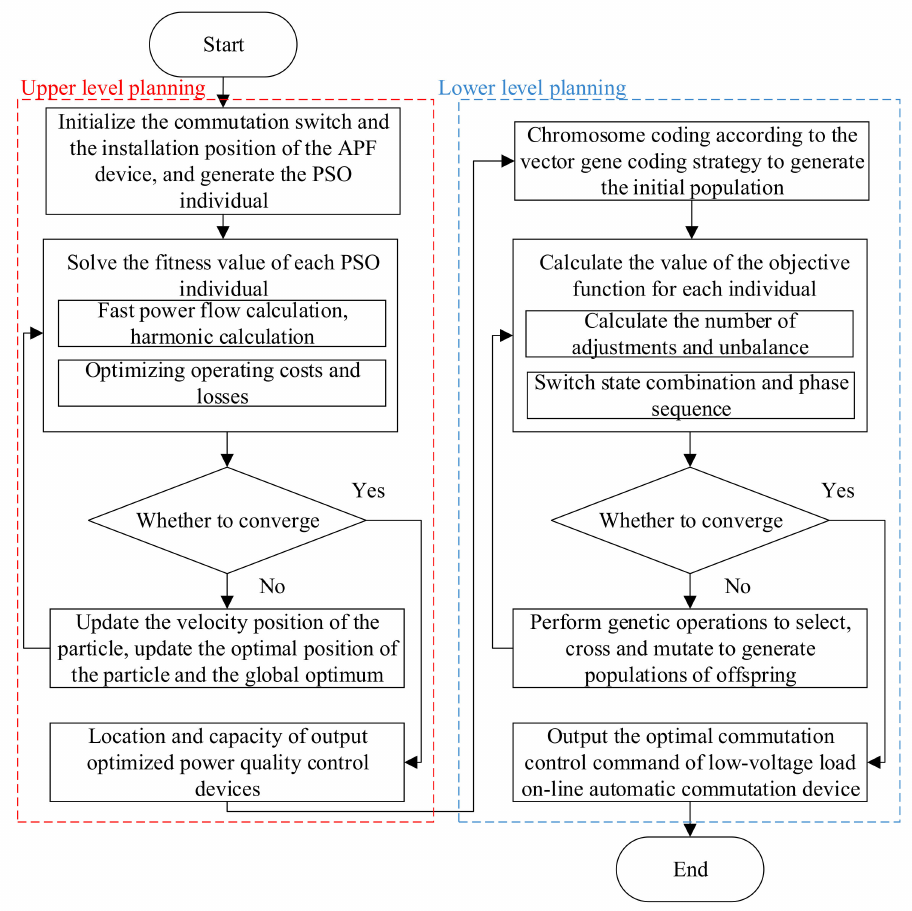
Figure 6. Two-tier planning process for power quality